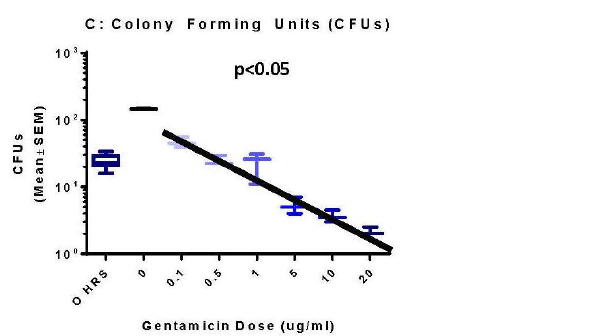
Figure 12. Linear regression comparison between the resazurin, OD, and CFUs of growing M. avium in the presence and absence of dose escalation of gentamicin. The comparison is between the 0 time point and 90 h and the impact of the different concentrations of gentamicin over the course of the 90 h. ( A ) Linear increase of resazurin as a component of enhanced stress, sub-statistical at p = 0.07. ( B ) OD as a component of fewer numbers of bacteria over time, p < 0.05. ( C ) CFUs demonstrating the surviving bacteria cultured at the end of each time point, p <